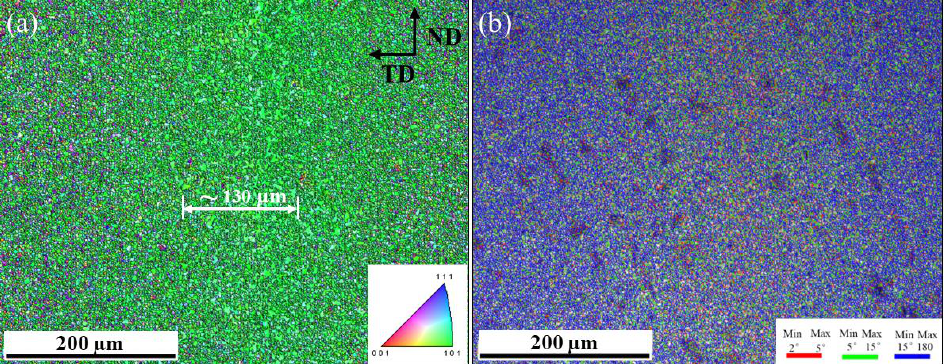
Figure 9. EBSD mapping and misorientation angle for the GNP/Al composite extruded by the porthole die. ( The subfigure is an inverse pole graph in figure 9 (a); the subfigure is misorientation angle range in figure 9 (b) )